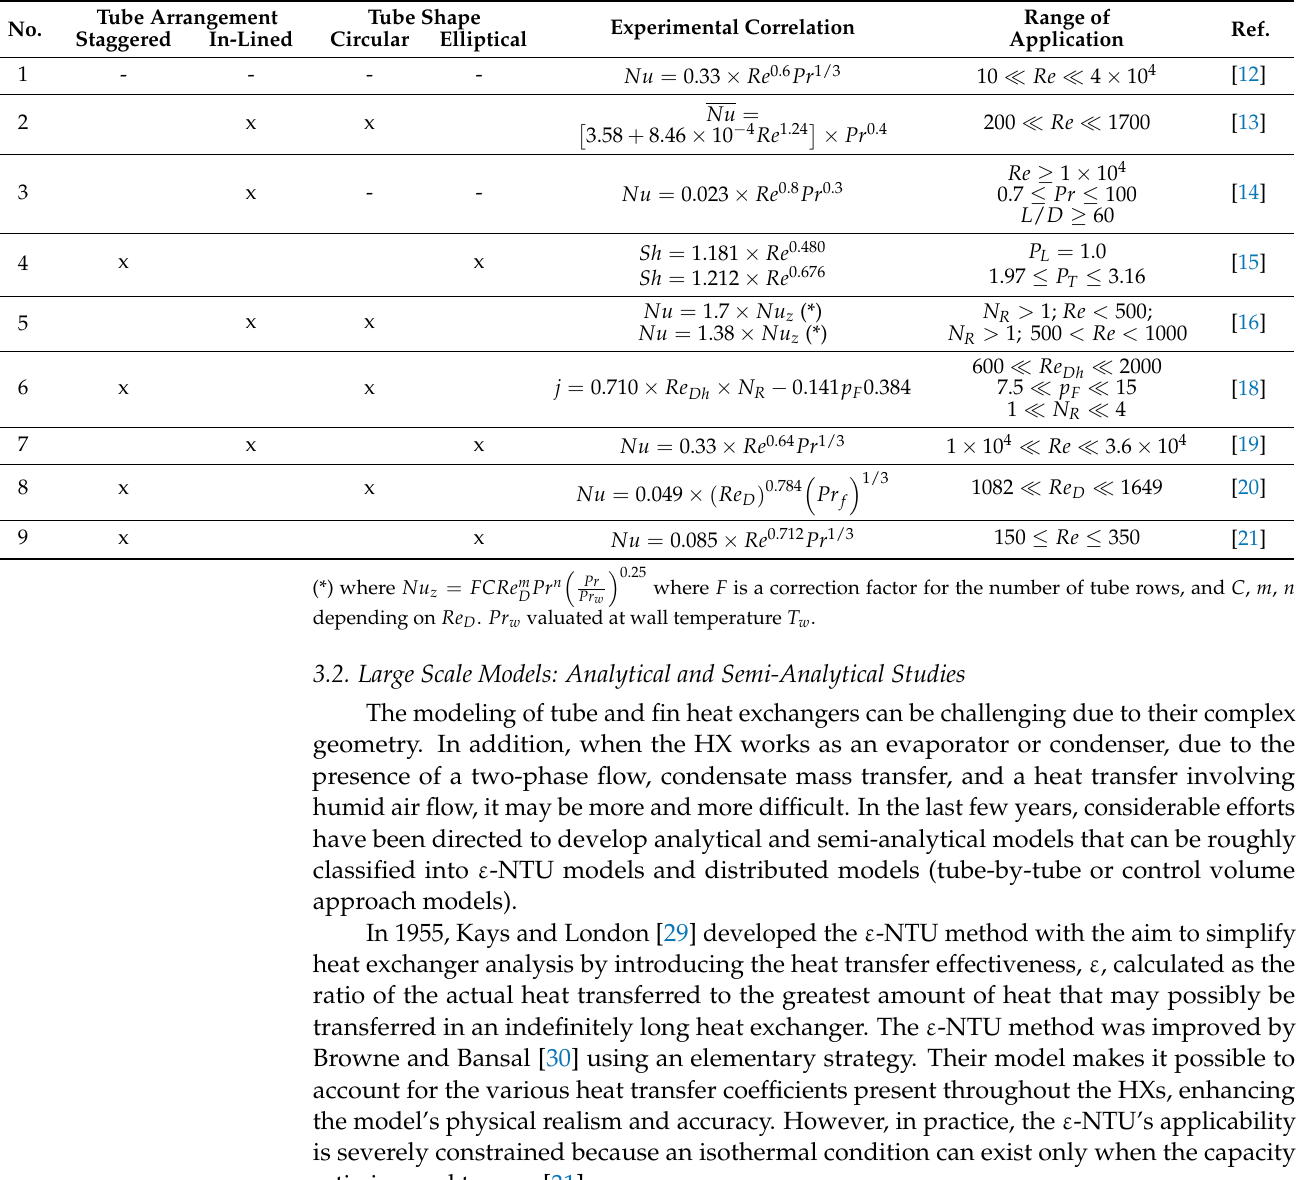
Table 2. Selected experimental correlations for plate-finned tube